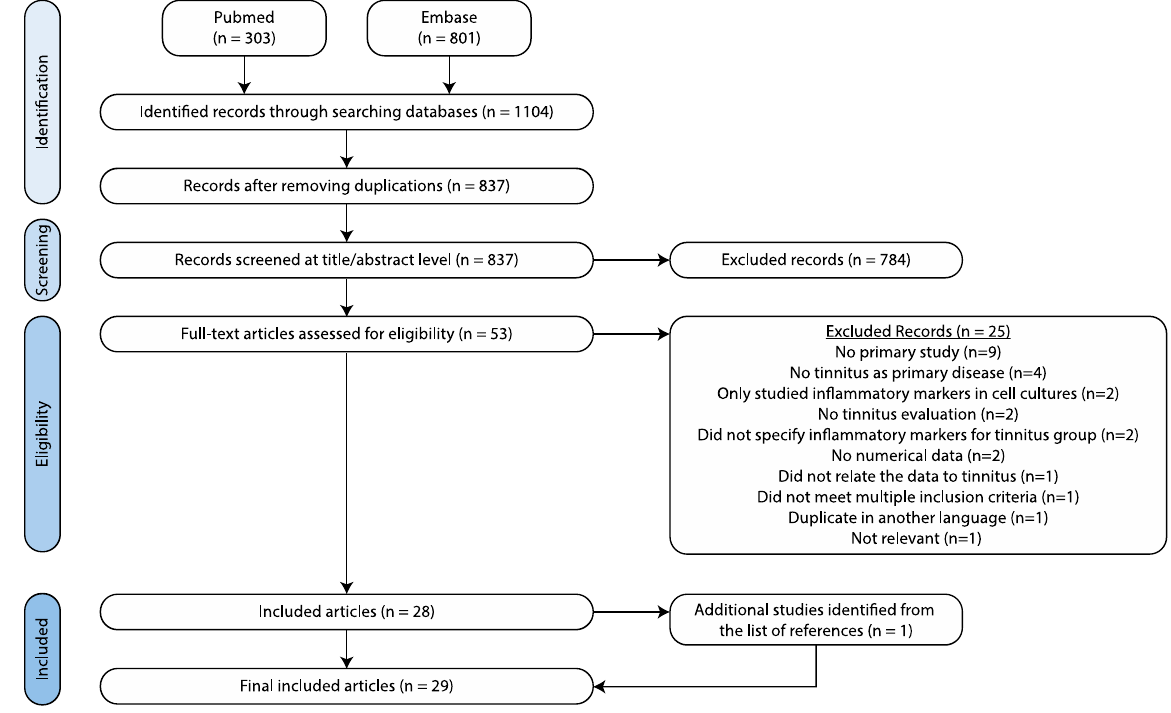
Figure 1. Search strategy.